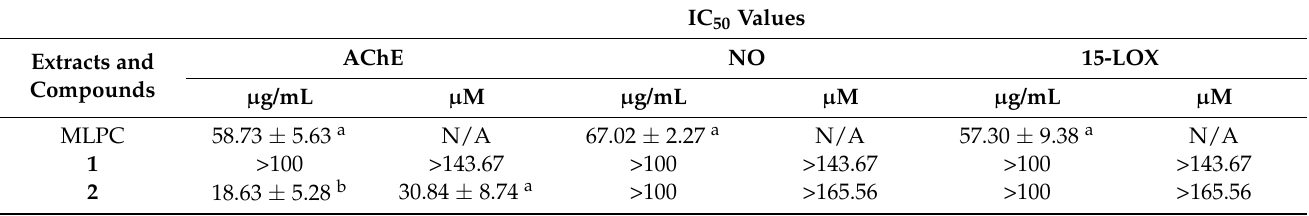
Table 1. Inhibitory concentrations (IC 50 in µ g/mL and µ M) of crude extracts of Phragmanthera capitata , Globimetula dinklagei and Tapinanthus bangwensis and their isolated compounds with reference controls (eserine) or